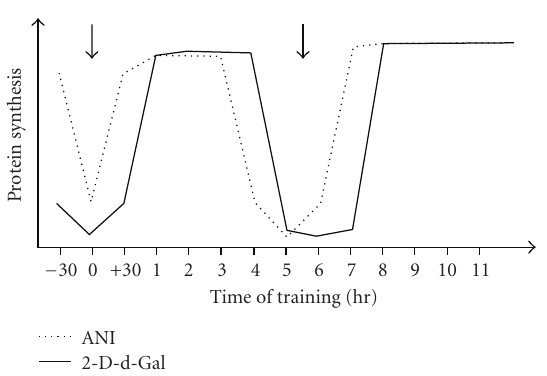
Figure 2: Two time-windows when protein synthesis is sensitive to inhibitors of protein synthesis, such as anisomycin (ANI) and glycoprotein synthesis, such as 2-d-Galactose (2-d-Gal).